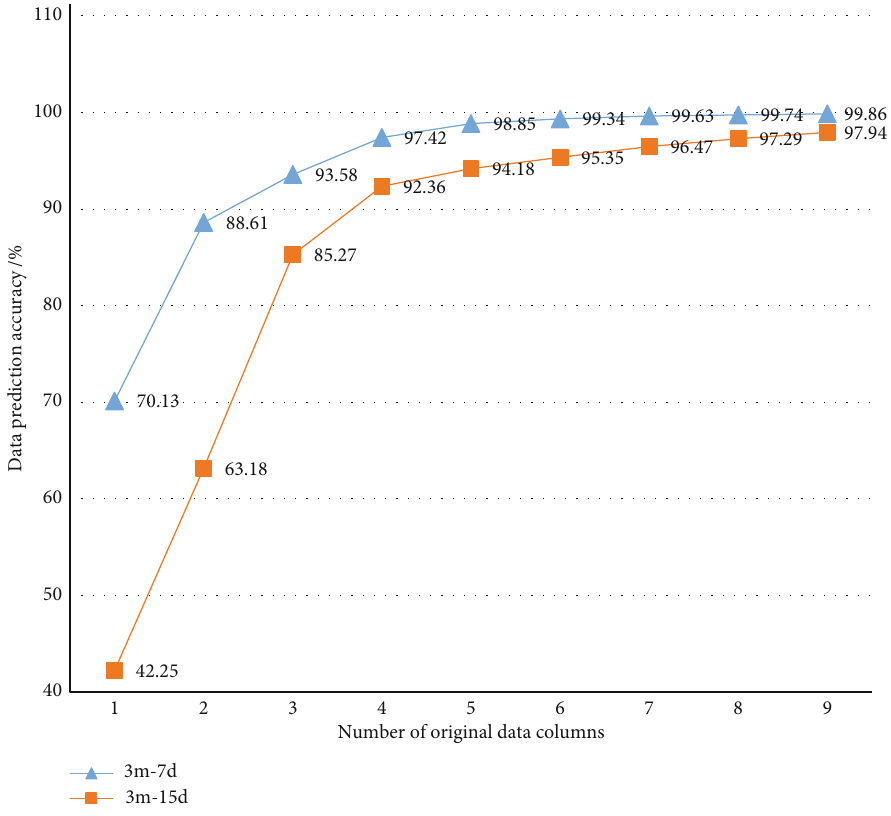
Figure 4: Relationship between the number of relevant data columns and the prediction accuracy.